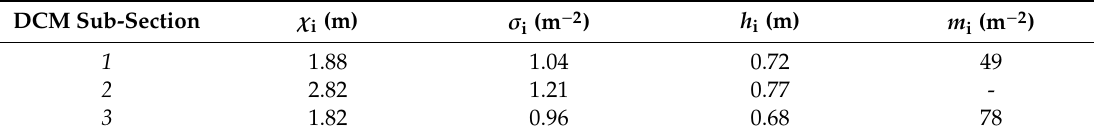
Table 3. Hydraulic and vegetative parameters referred to the flow rate Q 3 = 0.33 m 3 · s − 1 : χ i (m), σ i (m 2 ), h i (m) and m i (m − 2 ) are respectively the wetted perimeter, the flow cross sectional area, the water level at bankfull and the riparian vegetation density of each DCM sub-section. DCM